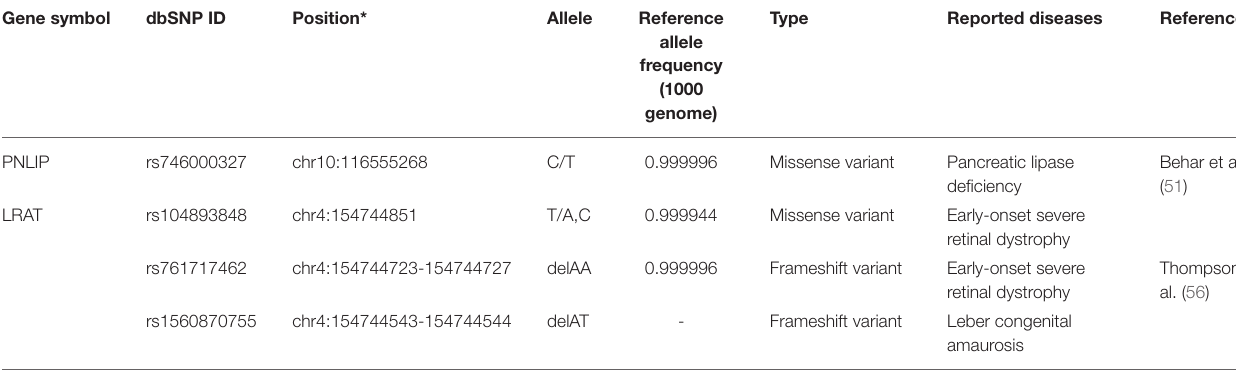
TABLE 2 | A list of pathogenic sequence polymorphisms of intestinal retinol absorption related genes.